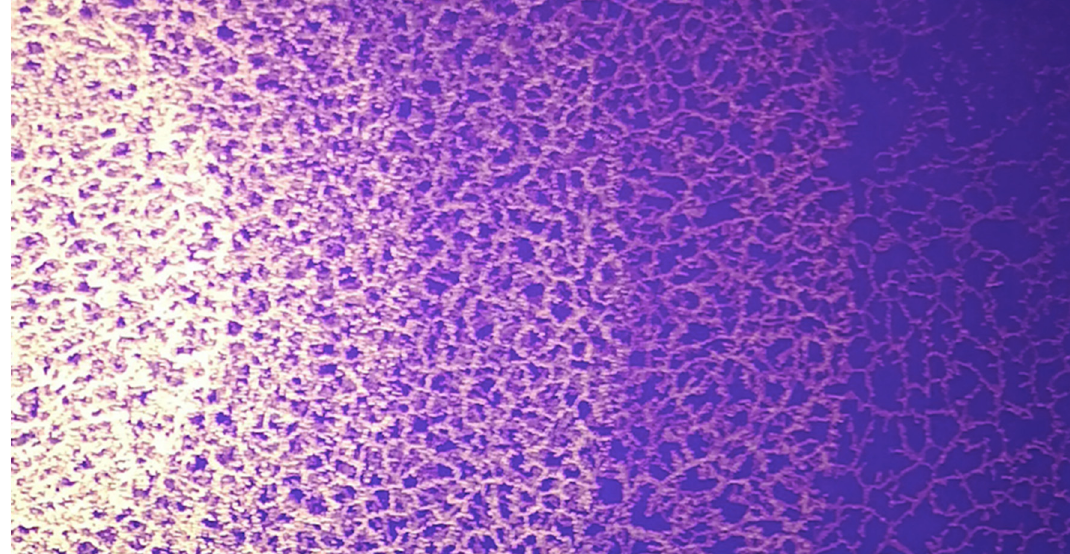
Figure 9. Textures of Light (2020) by Ana Margarida Rocha. Mesh texture detail. Author’s photo.